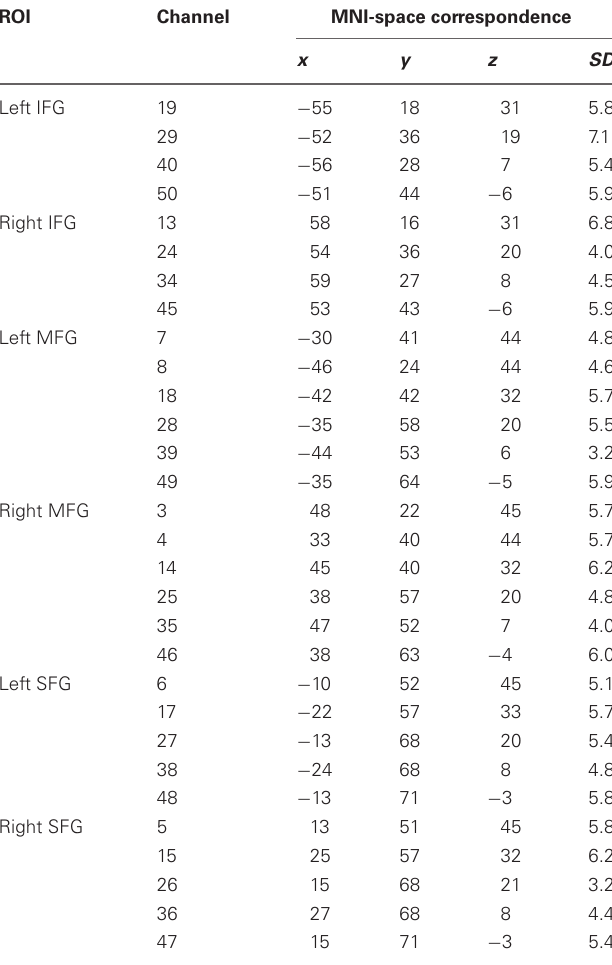
Table 1 | Regions of interest (ROI), channel position numbers, MNI coordinates, and estimated inter-subject variability